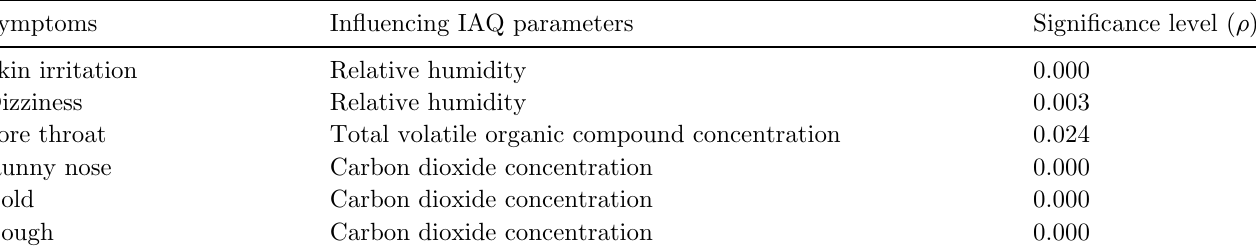
Table 13. Relationships between measured IAQ parameters and physical health symptoms in occupants during dry season.